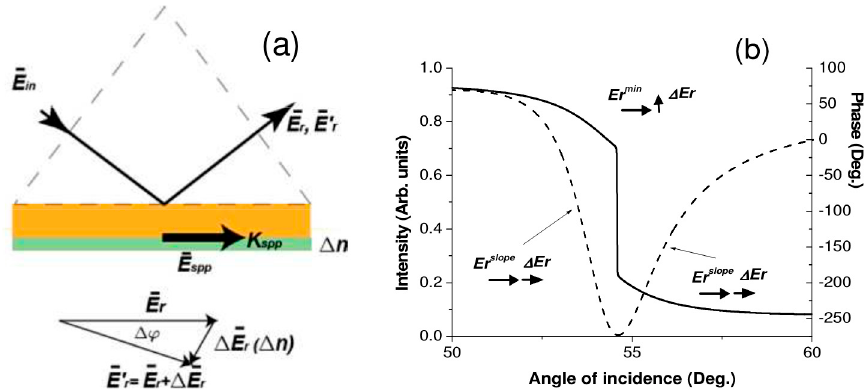
Figure 4. ( a ) SPP generation presented in electric vectors and ( b ) Reflection spectrum of intensity/angle (dashed line) and phase/angle (solid line). Adapted from [60], with permission from © 2009 Optical Society of America.